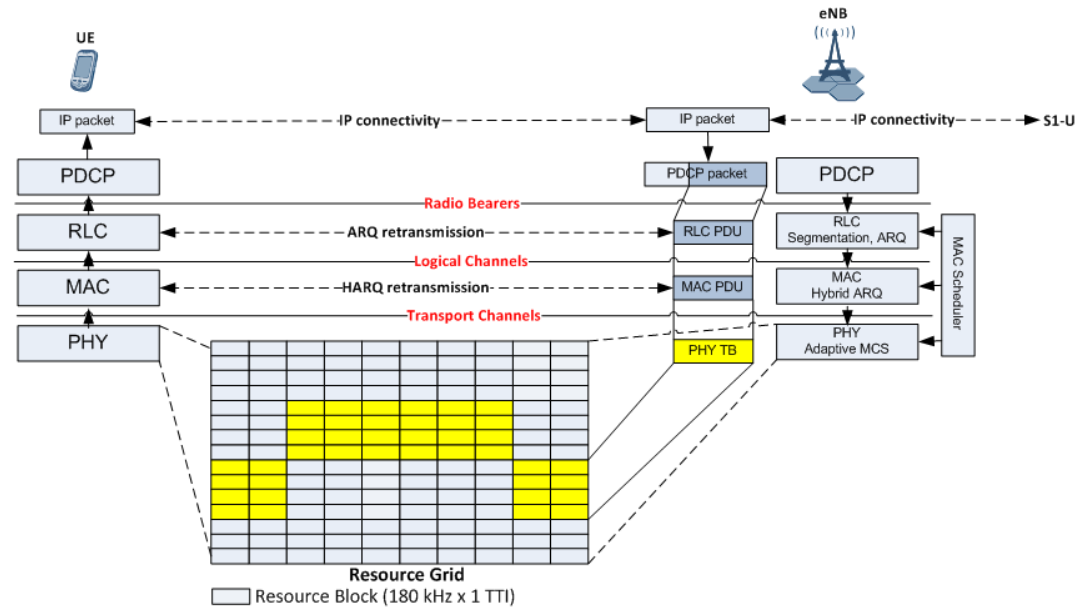
Figure 3. RAN network elements supporting mobile video delivery over 4G